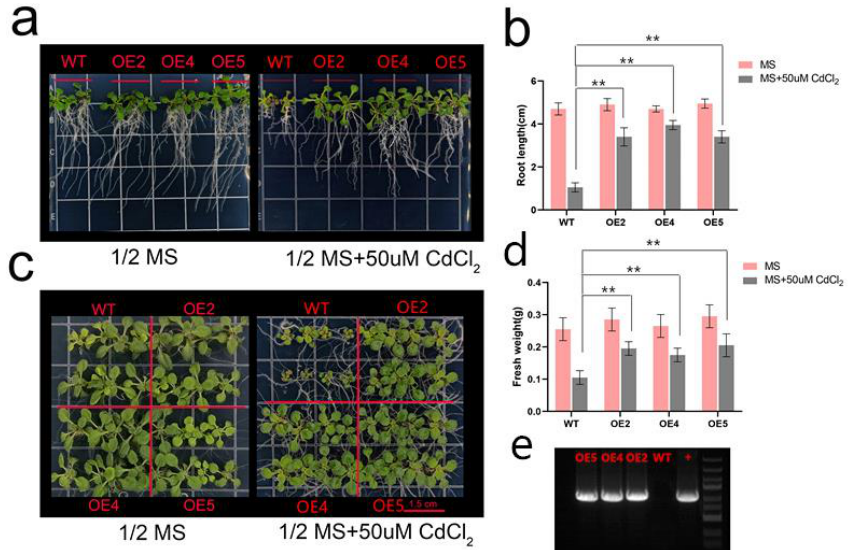
Figure 5. Functional verification analysis of I1AP2 in A. thaliana . ( a ) Root length of wild-type (WT) and transgenic A. thaliana under CdCl 2 stress. ( b ) Root length statistics of WT and transgenic A. thaliana under CdCl 2 stress. ( c ) Comparison of growth of WT and transgenic A. thaliana under CdCl 2 stress. ( d ) Fresh weight of WT and transgenic A. thaliana under CdCl 2 stress. ( e ) Agarose gel electrophoresis profile for the expression of I1AP2 in WT and transgenic A. thaliana (OE2, OE4 and OE5). The + band was amplified with I. lactea cDNA and ORF primers of I1AP2 , serving as positive control . ‘ ** ’ shows the significance level of p < 0.01.